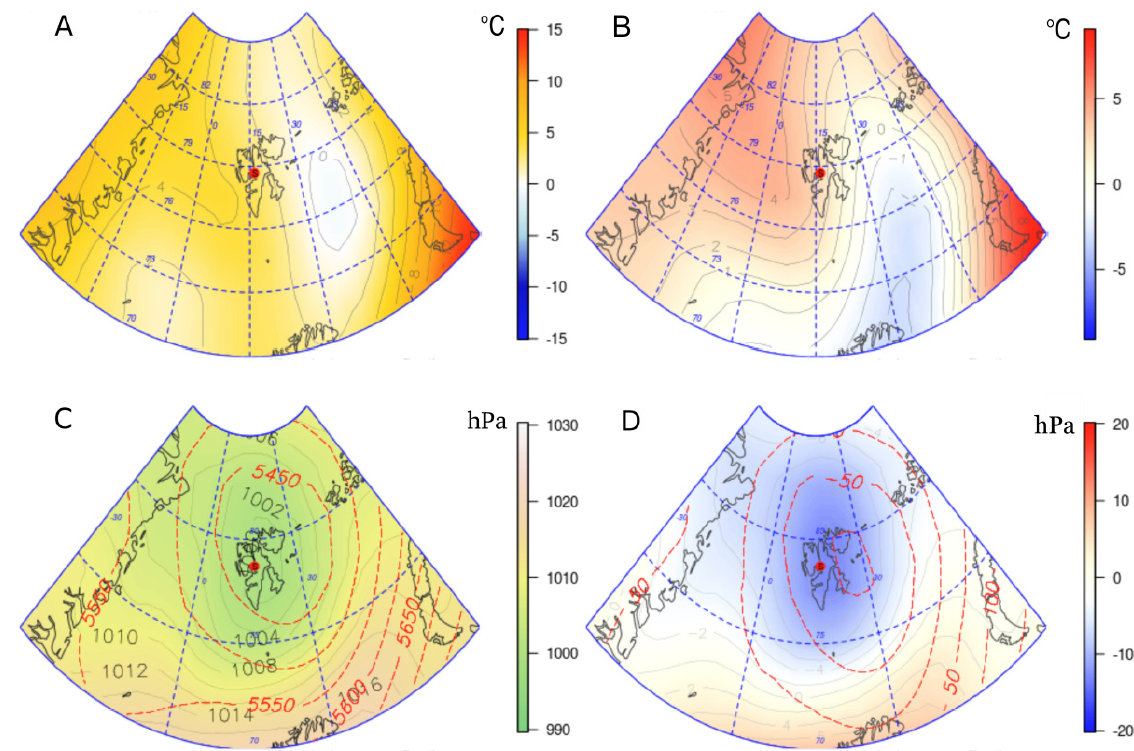
Figure 7. Air temperature at an altitude of 850 hPa (T850) (°C)—grey solid line ( A ) and its anomalies ( B ) and the average daily sea-level pressure distribution (SLP) (hPa)—grey solid line and geopotential height of 500 hPa (m)—red dotted line ( C ) and its anomalies ( D ) for 20 July 2016. The red point shows the research area.